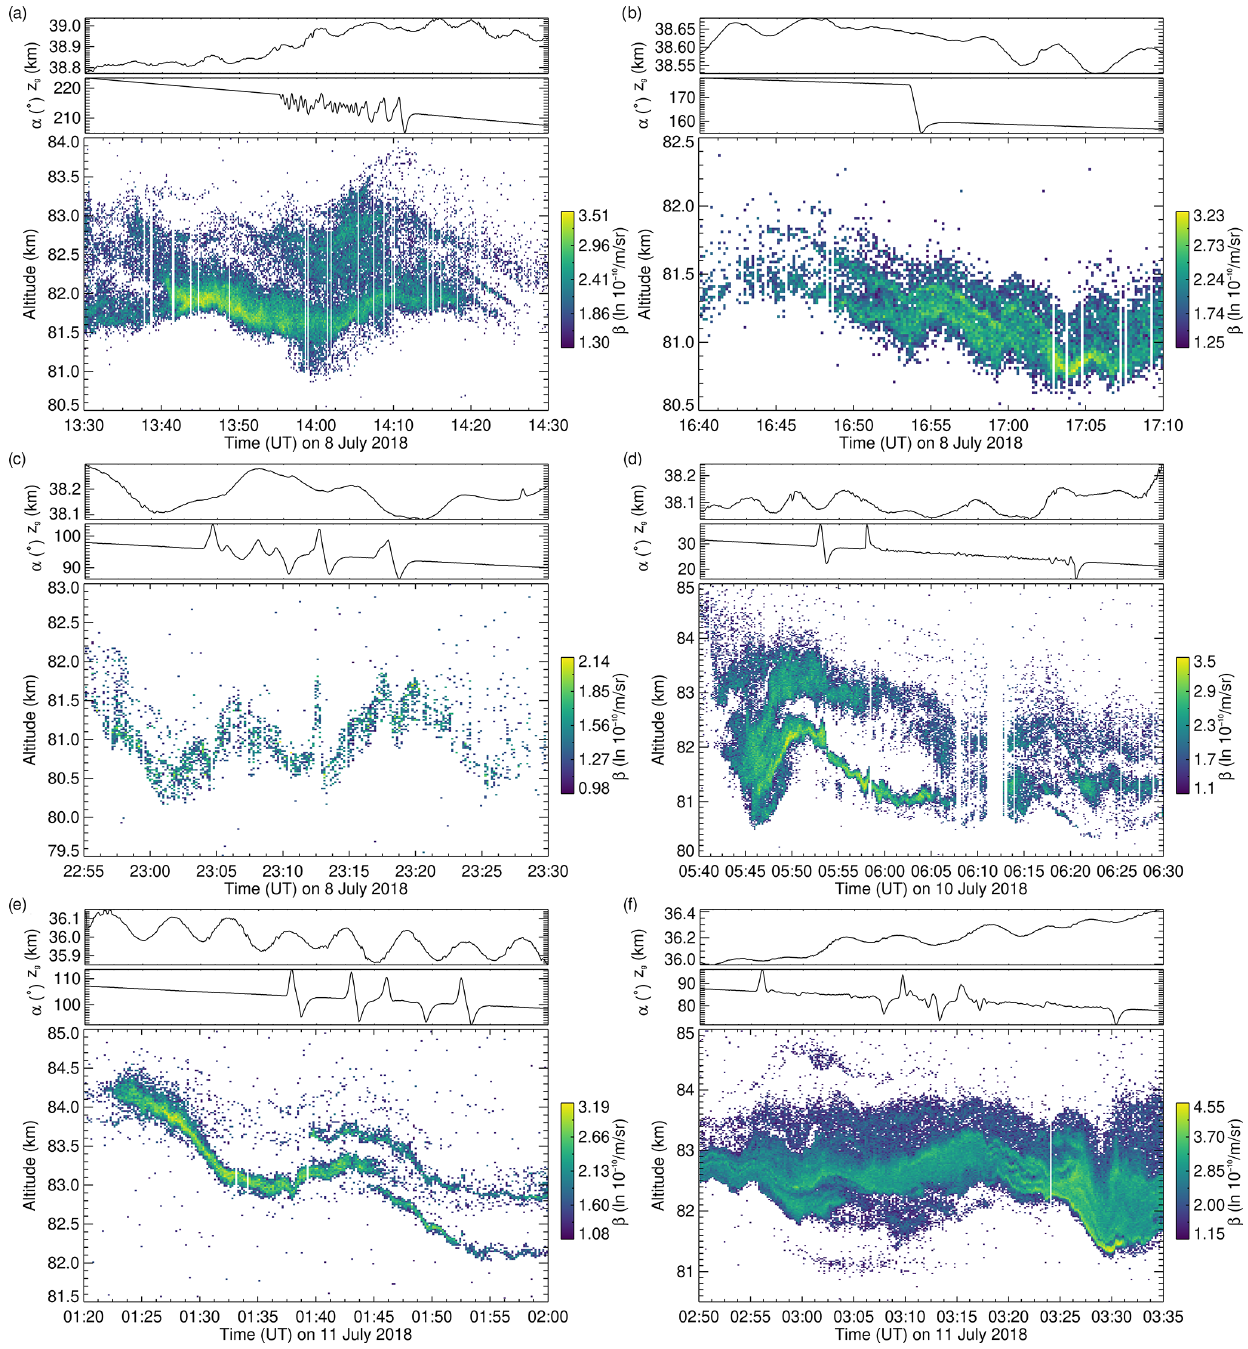
Figure A1. Floating altitude z g , azimuth angle α , and respective PMC detections for the six periods with deviations from the nominal rotator motion during PMC conditions. The floating altitude has been taken into account in PMC altitude calculations.